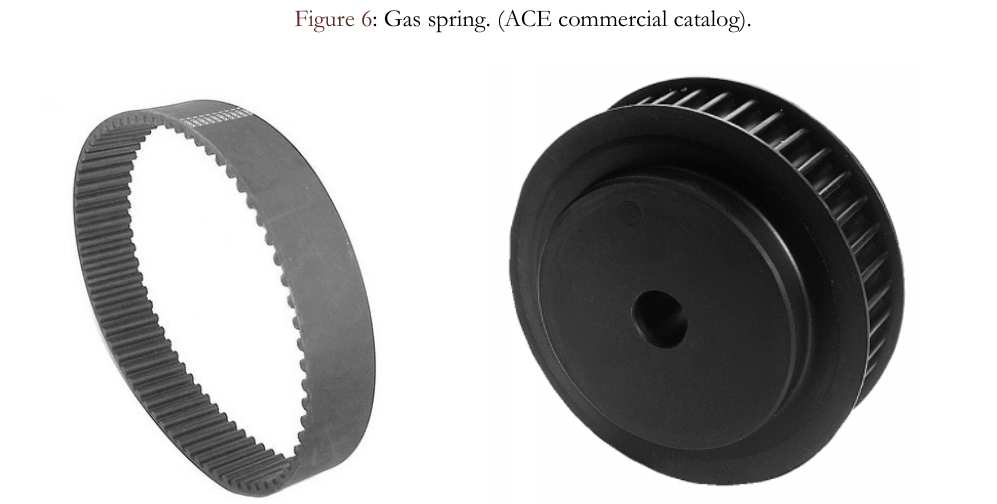
Figure 7: Belts and